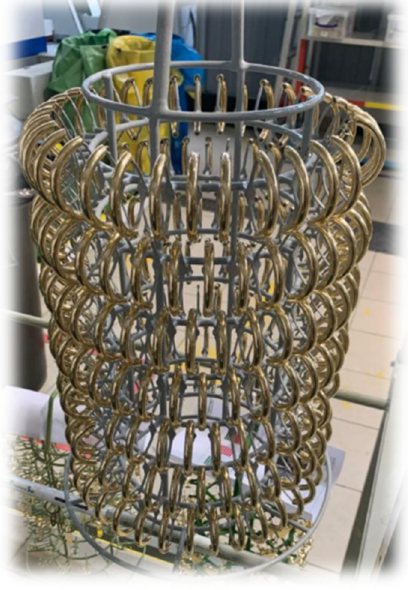
Figure 7. Galvanoplasty expositor — “ring”.